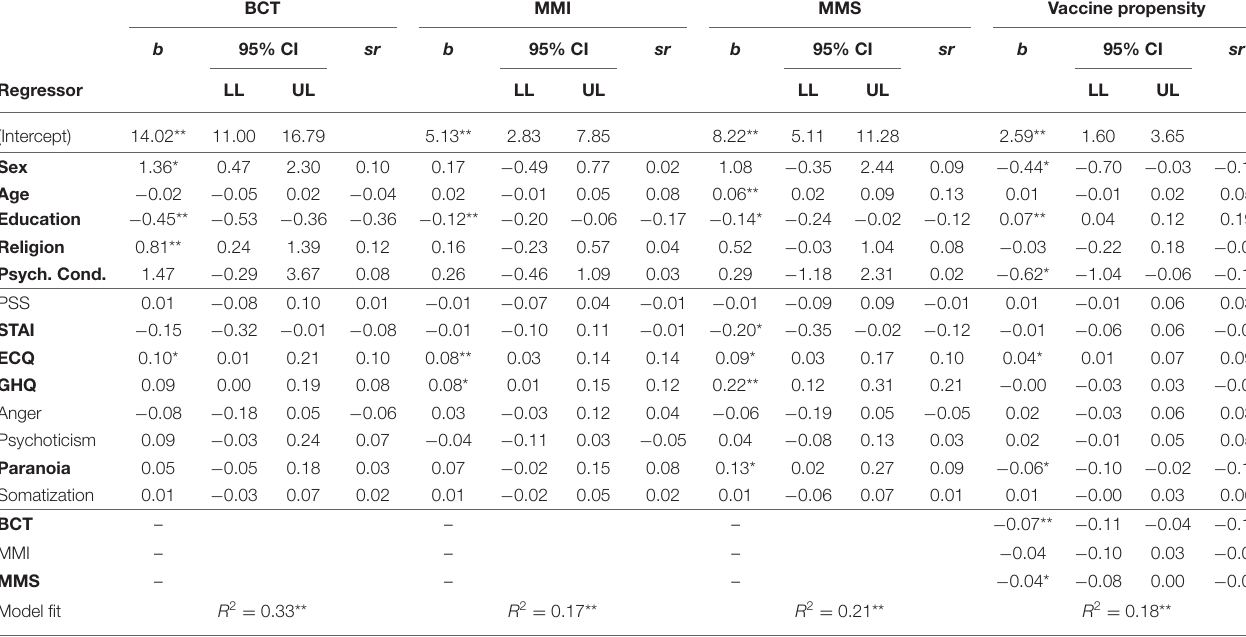
TABLE 4 | Regression results for the three BOC-19 scales and vaccine propensity. BCT MMI MMS Vaccine propensity